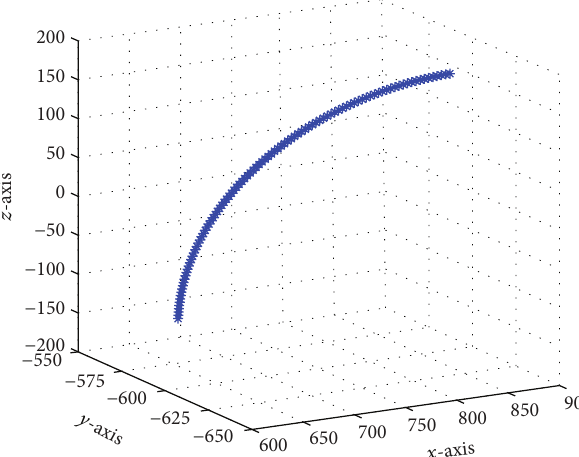
Figure 3: Trajectory of the robot in